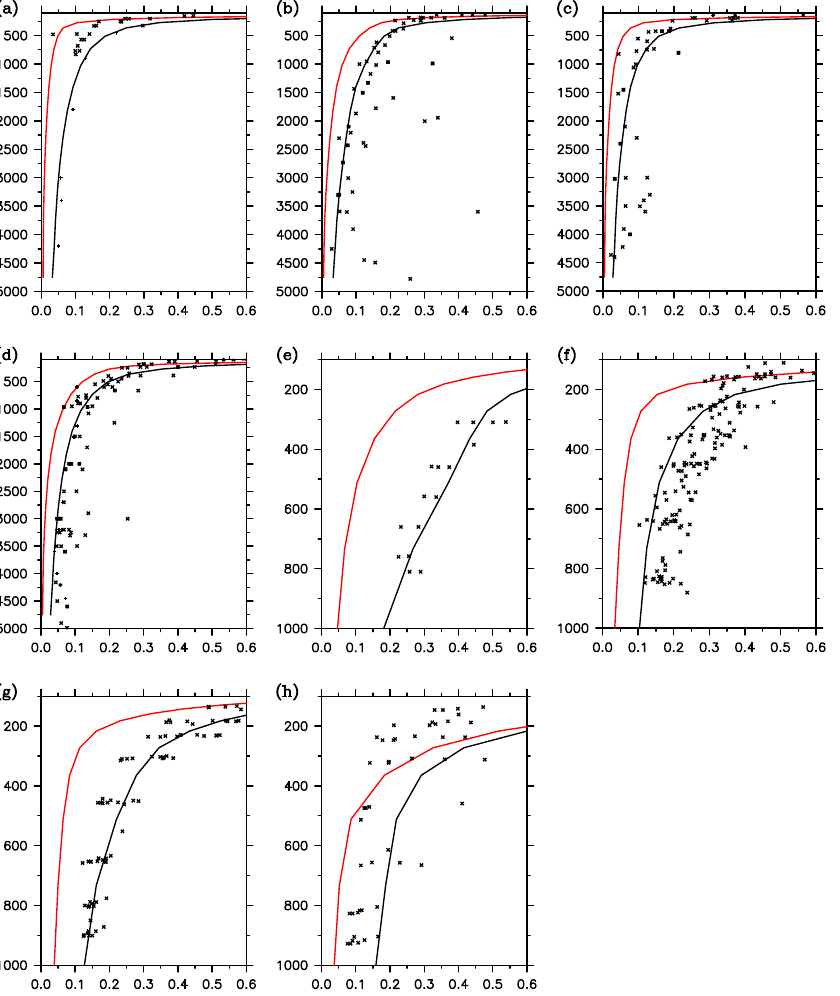
Figure 4. Modelled and observed total POC concentrations (µM) in different regions of the ocean: (a) western, (b) oligotrophic, and (c) east- ern North Atlantic Ocean; (d) Hawaii; (e) northwestern, (f) northeastern, (g) central, and (h) southern Pacific Ocean. The continuous lines are concentrations averaged over the region marked by the blue and green rectangles on the map of Fig. 3: without (in red) and with the reactive continuum (RC) parameterisation (in black). The black speckles are observations in the respective regions from Druffel et al. (1992) and Lam et al. (2011,